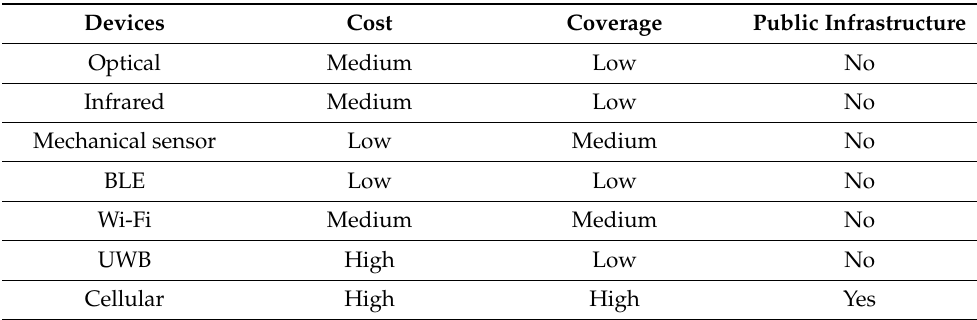
Table 4. Comparisons of RF technologies for indoor localization.